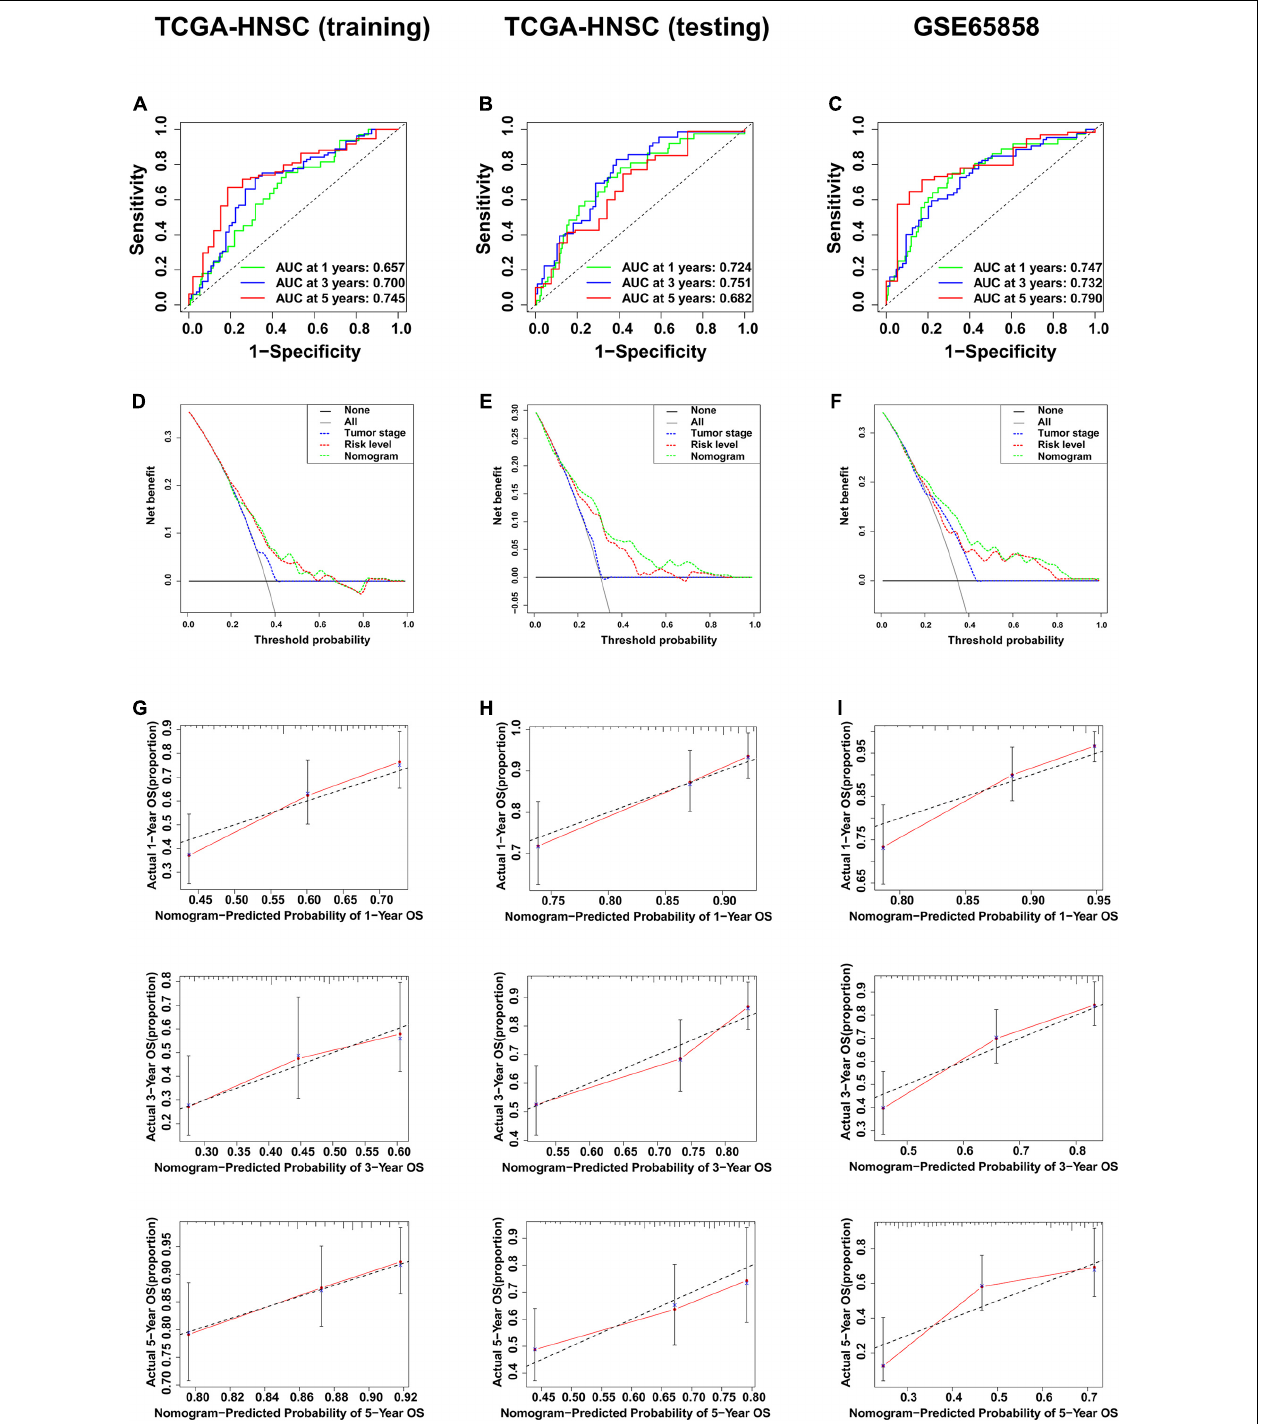
FIGURE 10 | Validation of the multi-factor prognostic model. (A) AUC in ROC analysis for the prognostic model in TCGA training cohort. (B) AUC in ROC analysis for the prognostic model in TCGA testing cohort. (C) AUC in ROC analysis for the prognostic model in GSE65858. (D) DCA for the prognostic model in TCGA training cohort. (E) DCA for the prognostic model in TCGA testing cohort. (F) DCA for the prognostic model in GSE65858. (G) Calibration plot for 1-, 3-, and 5-year overall survival in TCGA training cohort. (H) Calibration plot for 1-, 3-, and 5-year overall survival in TCGA testing cohort. (I) Calibration plot for 1-, 3-, and 5-year overall survival in